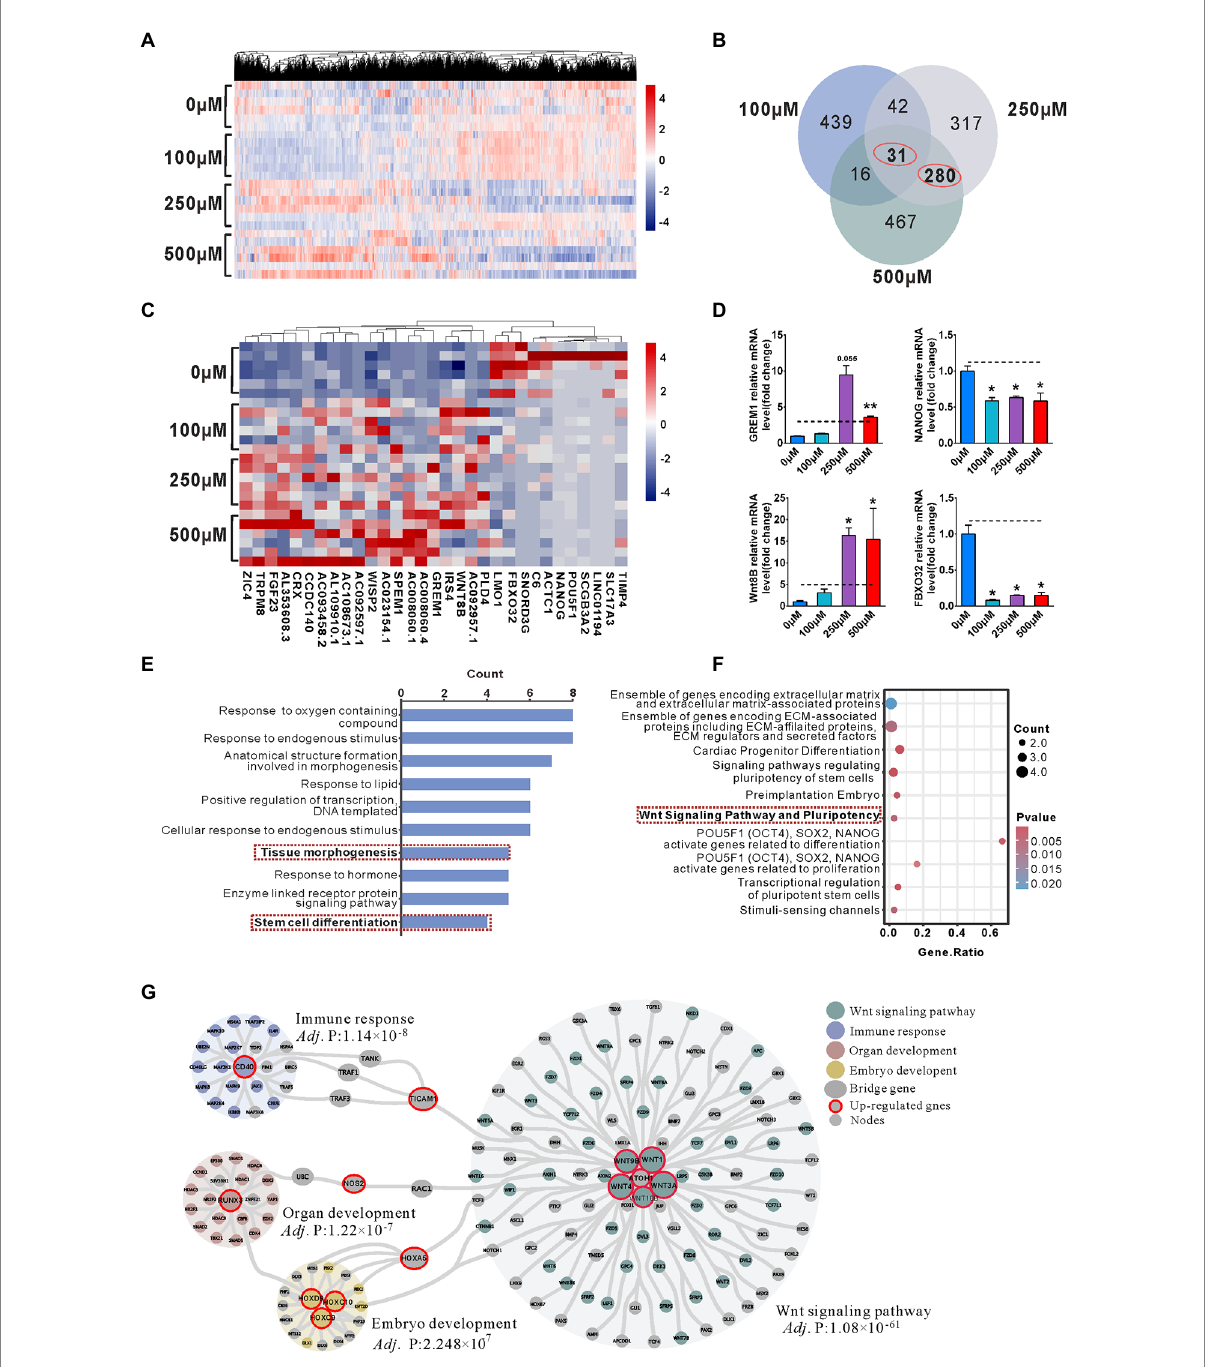
FIGURE 4 Enrichment of Wnt signaling pathway activation involved in the reduction of NPCs pool in the VPA treated Organoids. (A) Hierarchical clustering heatmap for DEGs from the organoids of control (0 μ M) and VPA treated organoids (100, 250, and 500 μ M) on day 28 ( n = 6 organoids each). (B) Venn diagram of co-regulated DEGs by VPA. (C) Hierarchical clustering heatmap for the co-regulated 31 DEGs. (D) The qRT-PCR was conducted to confirm the results of RNA-seq ( n = 3 organoids each). (E) Enriched top 10 GO-biological process terms. (F) Top 10 enriched pathways. (G) PPI network analyses screened out four main communities. * p > 0.05, ** p >